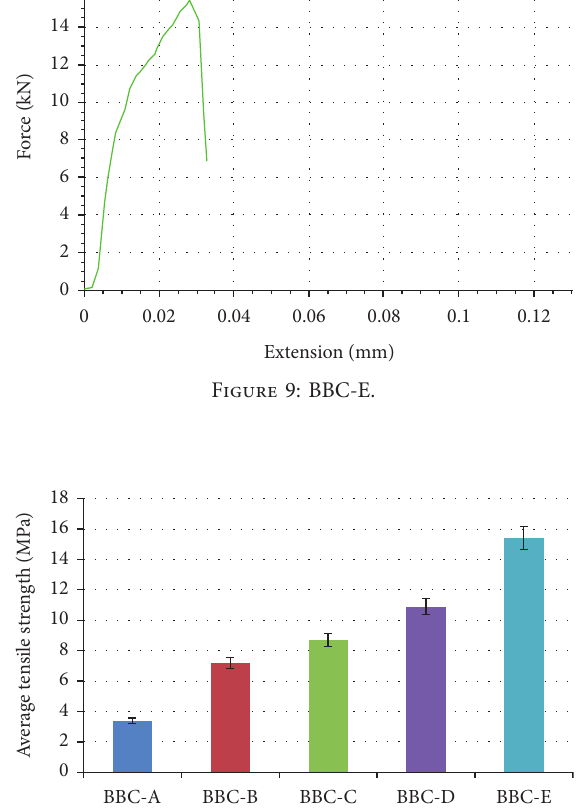
Figure 13: Thermal insulation behavior of